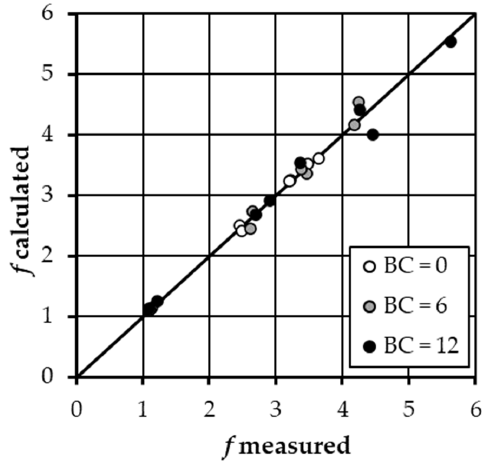
Figure 7. Comparison between the measured friction factor values, and the ones, f , calculated by Equations (5), (12), (13) and (14).